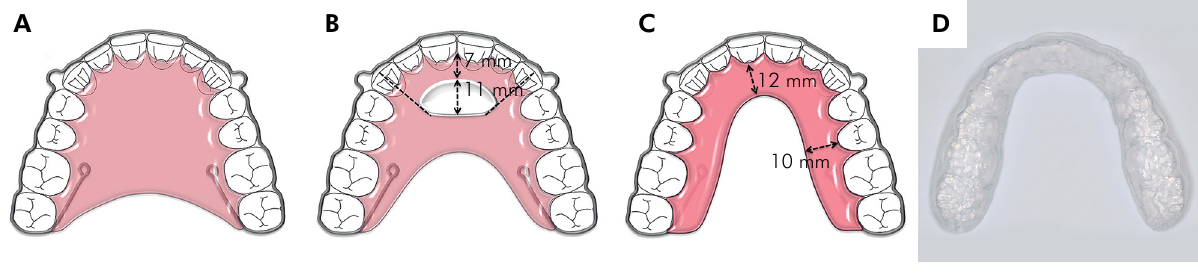
Figure 1. A. Conventional wrap-around retainer; B. Wrap-around retainer with an anterior opening. C. Horseshoe-shaped or “U” wrap-around retainer. D. Clear thermoplastic